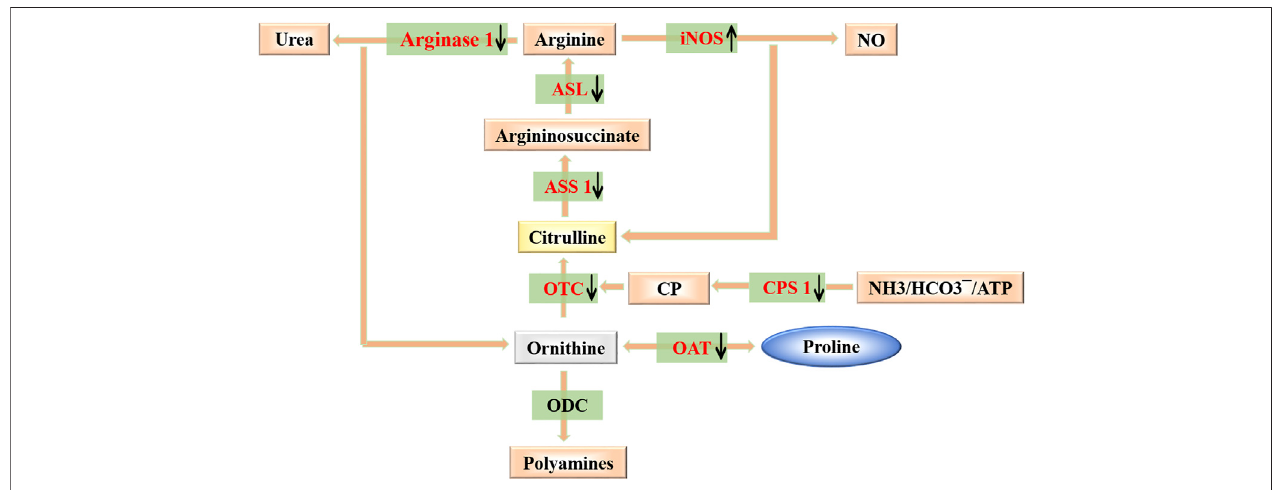
FIGURE 8 | Modulating arginase-ornithine pathway. Scheme for the catabolism of arginine to ornithine/urea or citrulline/NO, production of polyamines and anabolism and catabolism of proline. Also shown is the recycling of citrulline into arginine. Targets of TL against PF are colored in red.